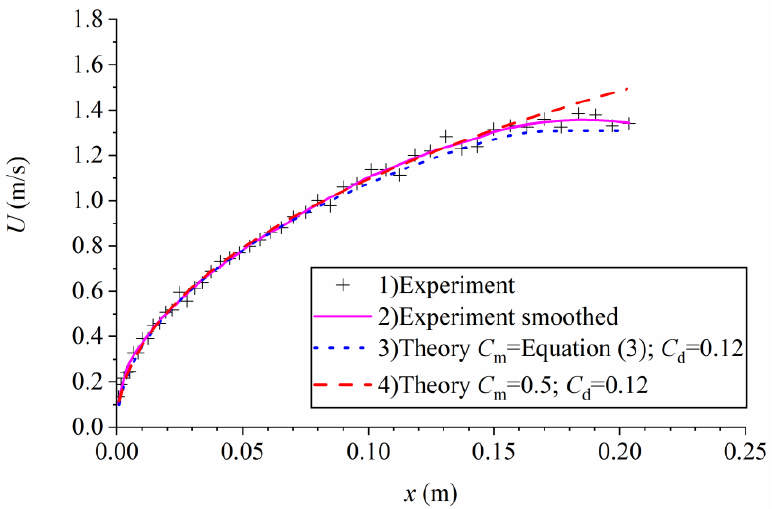
Figure 7. Displacement-velocity curves after resistance coefficient correction for the case ρ = 0.4, L 0 = 2.31 and h = 0.089.